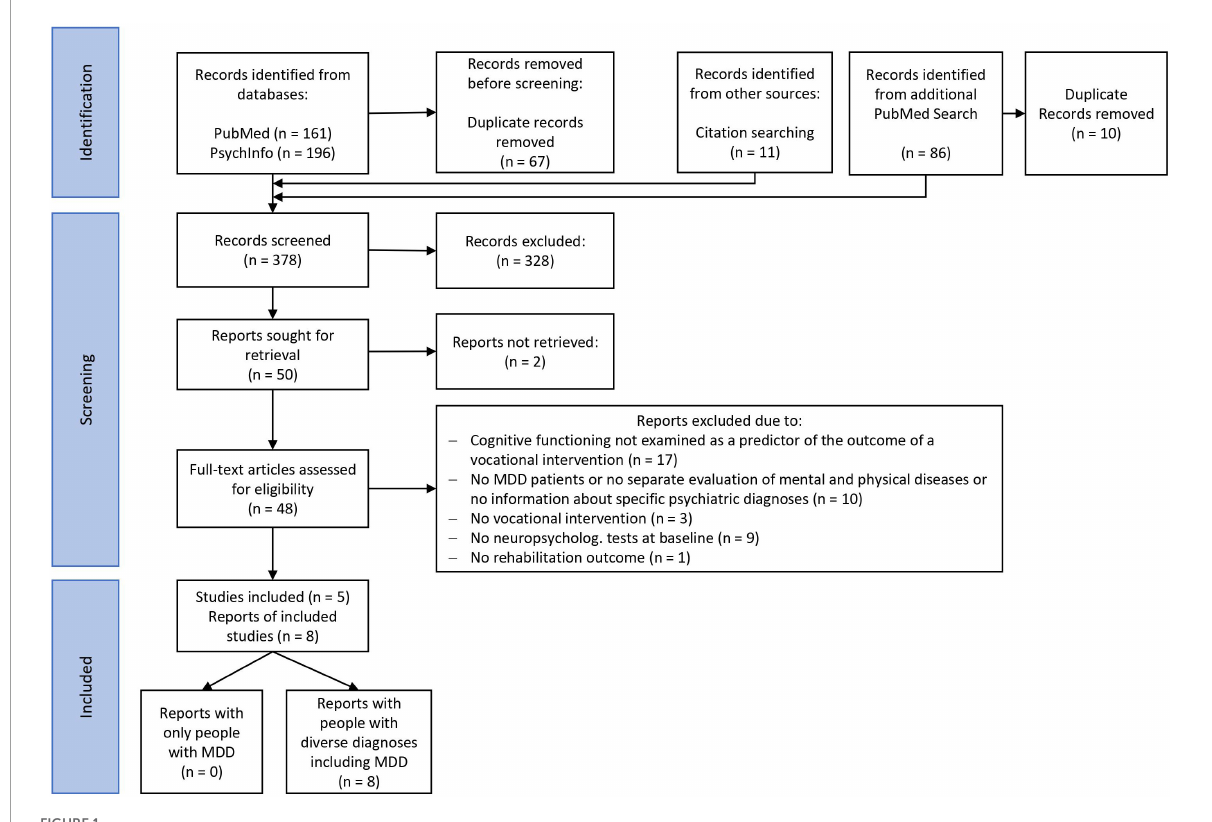
FIGURE1 Preferred reporting items for systematic reviews and meta-analyses